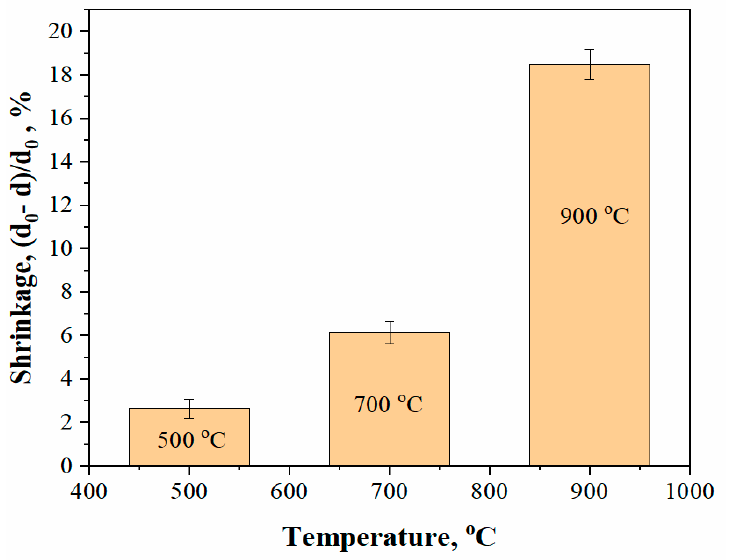
Figure 6. Shrinkage of ceramic samples, obtained by annealing of cement-salt stone in the temperature range of 500–900 °C.